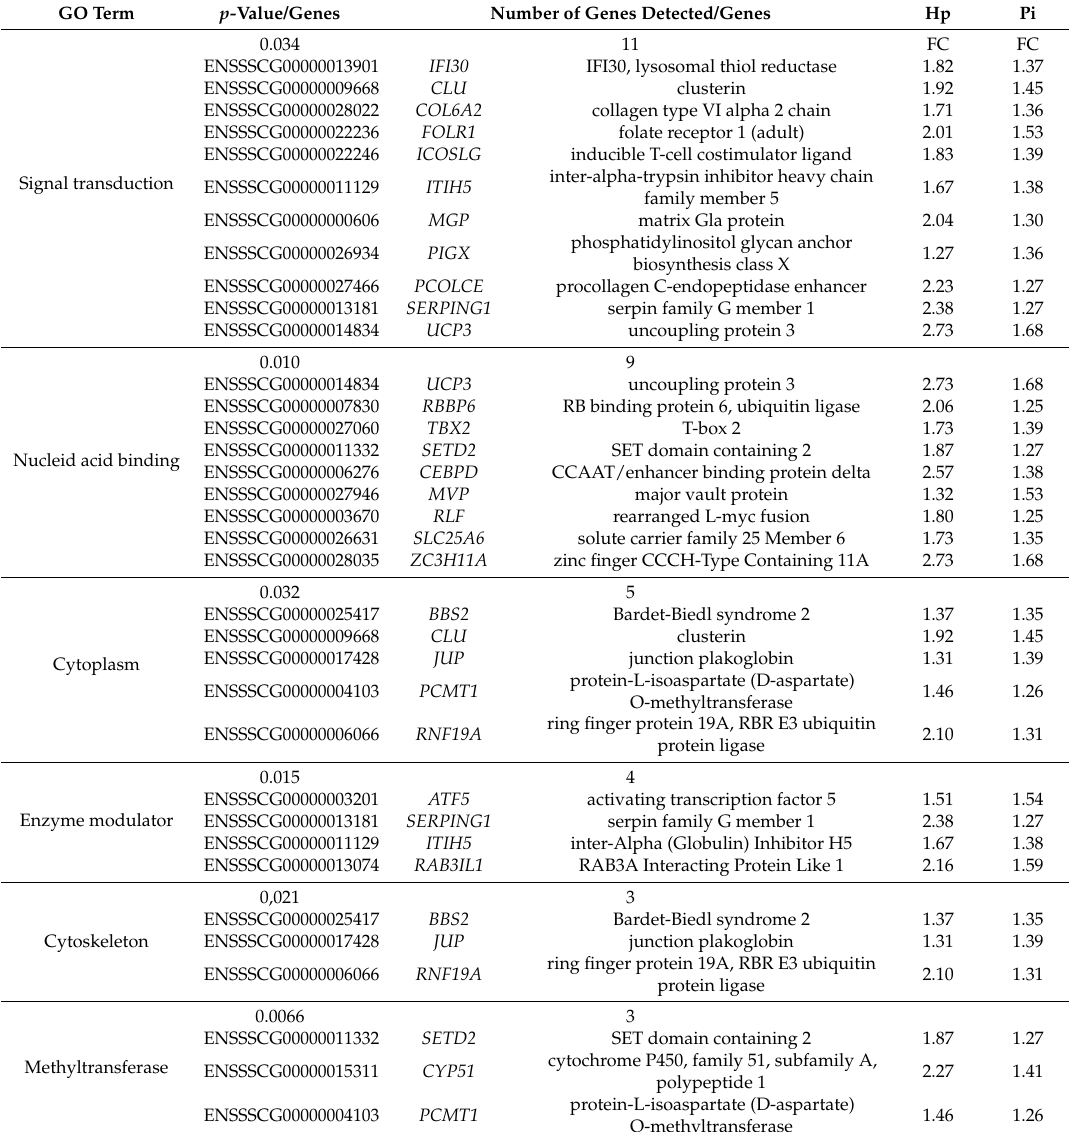
Table 1. The detected significant Gene Ontology terms based on genes differentially expressed between pigs differing in terms of muscle